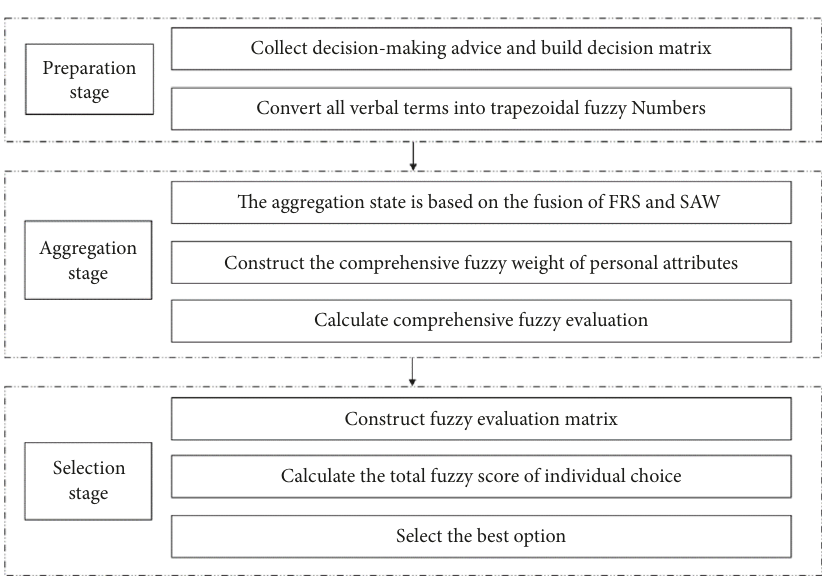
Figure 2: The conceptual framework of the proposed